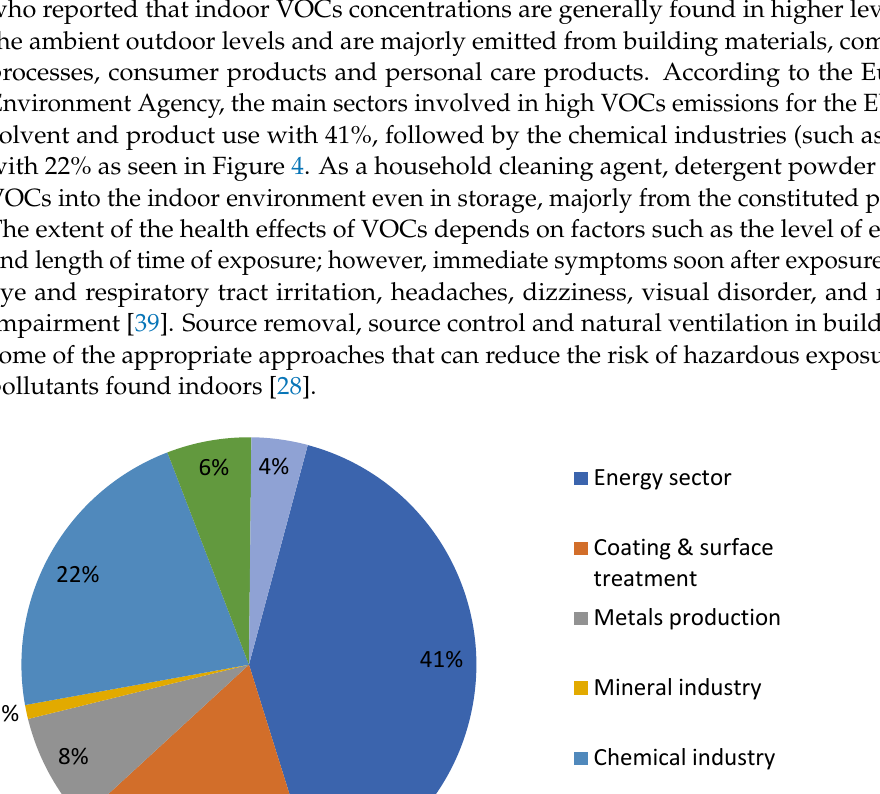
Figure 5. Monitored CO 2 concentration and RH across the workstations.